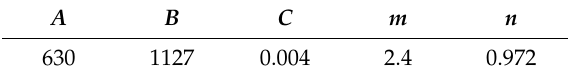
Table 3. The material constant of JC model obtained by orthogonal cutting experiment